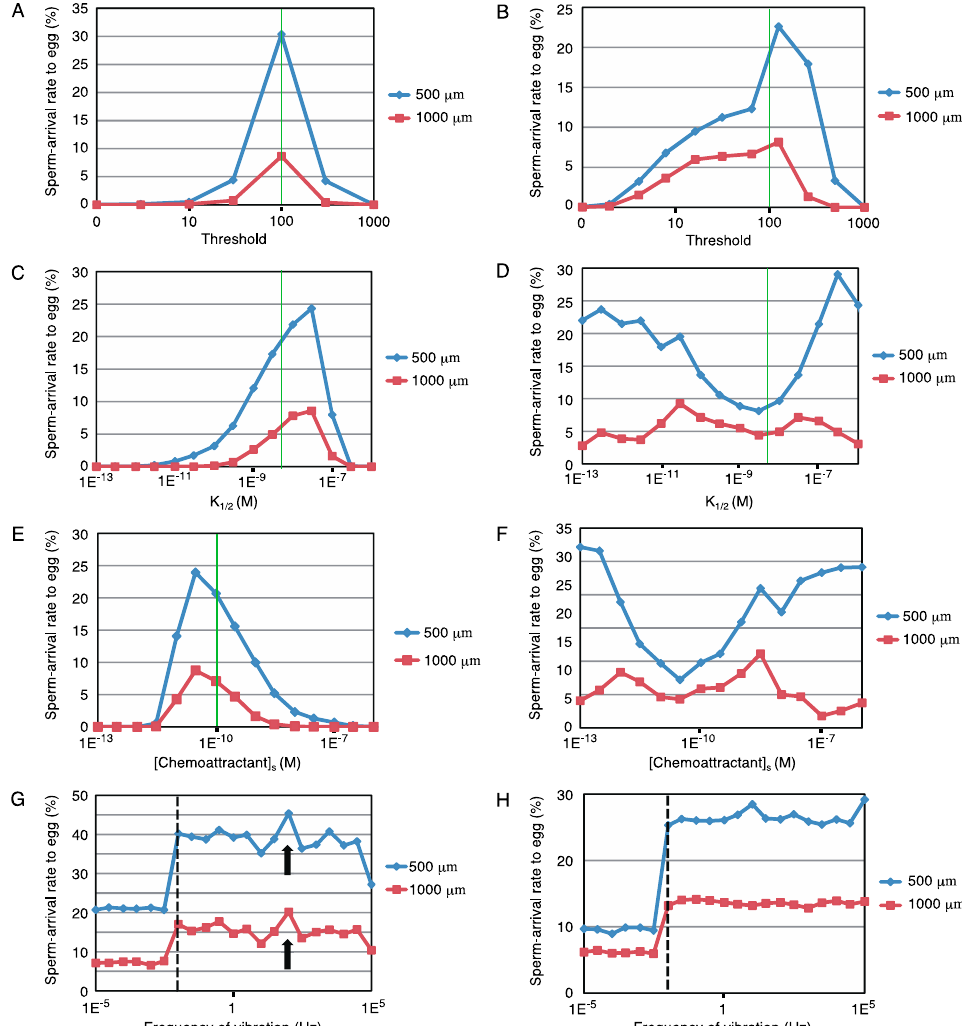
Figure 4. Further analysis of models. ( A – F ) Summarized graphs of simulations with modification in parameters and the threshold for [cGMP] i , K 1/2 , and [Chemoattractant] s . The y -axis shows the egg-arrival rates of sperm ( n = 10,000), with the modification in each parameter shown as the abscissa axis. ( A , C , E ) correspond to the sea urchin models. ( B , D , F ) represent the starfish models. Green lines indicate the original values of the parameters. ( G , H ) Effects of physical disturbances in the sea urchin model ( G ) and starfish model ( H ). The y -axis shows the egg-arrival rates of sperm ( n = 10,000), with the frequency of sine-wave oscillation shown as the x -axis. The broken line represents 0.01 Hz, and the arrowhead in G indicates a local maximum at 100 Hz.